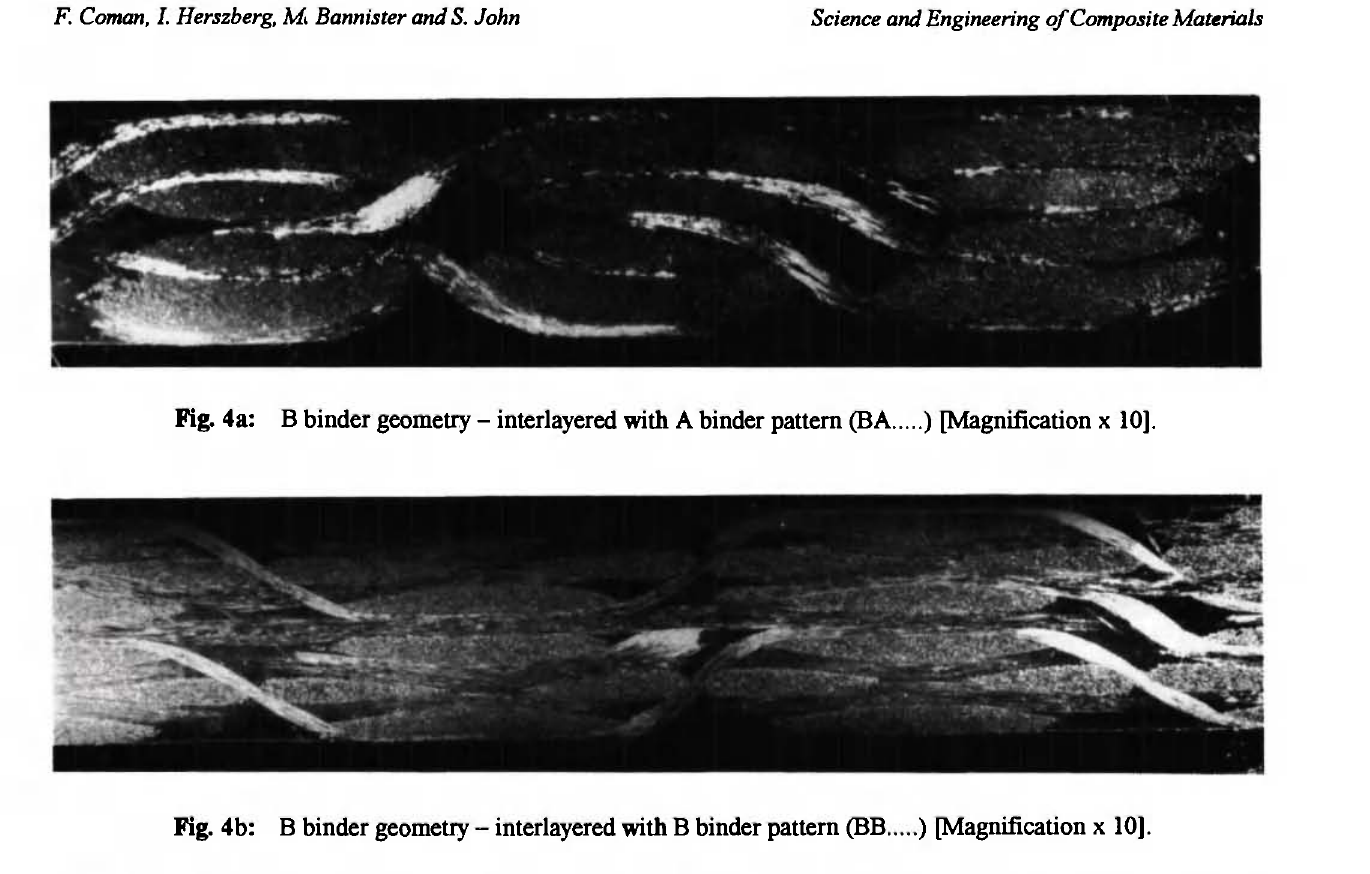
Fig. 4b: Β binder geometry - interlayered with Β binder pattern (BB ) [Magnification χ 10].